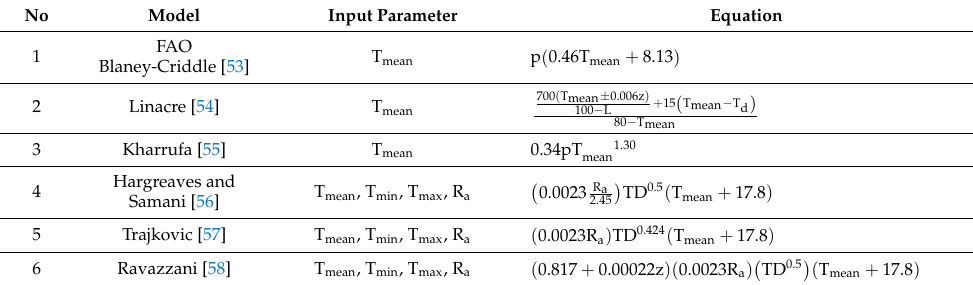
Table 2. The temperature-based empirical ET formulations considered in this study.